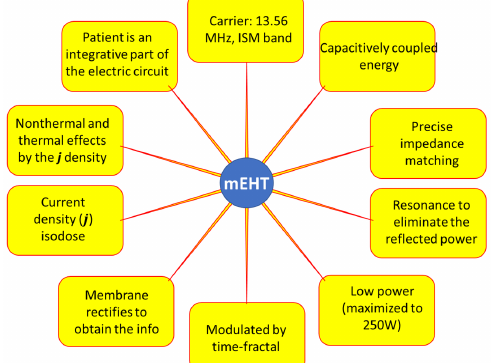
Figure 8. The technical conditions of mEHT. The realization of the method rigorously accommo- dates and utilizes the complexity of the heterogenic impact of mEHT to arrest the proliferation of cancer and degrade the developed tumor